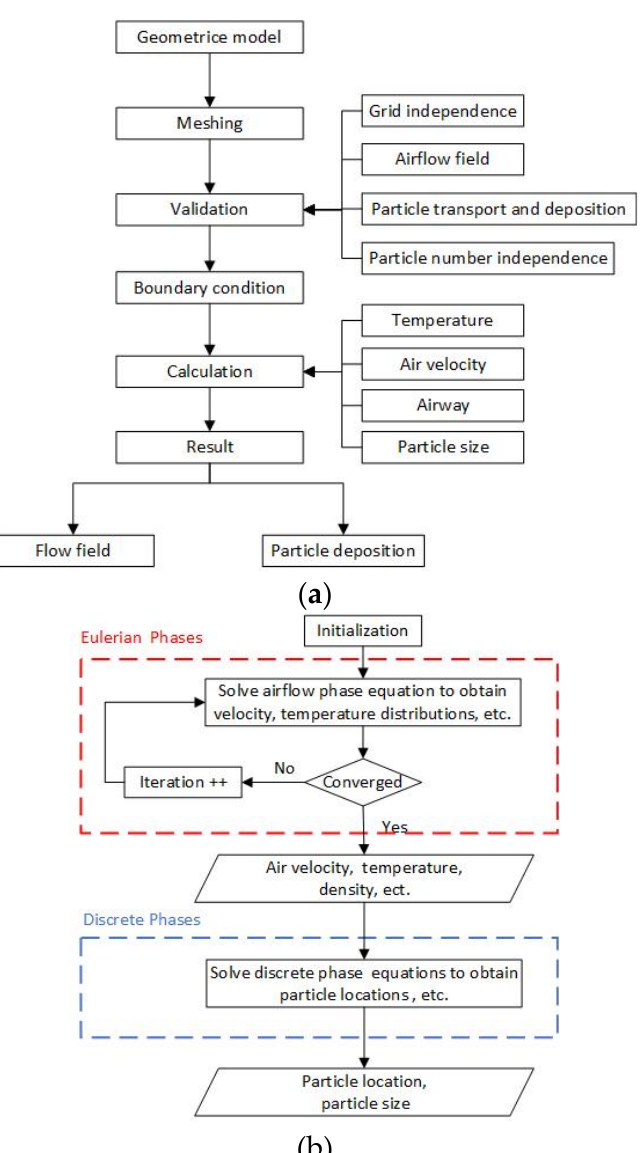
Figure 3. Workflow and calculation process: ( a ) Research route and structure; ( b ) Solving process using the Euler–Lagrange method.